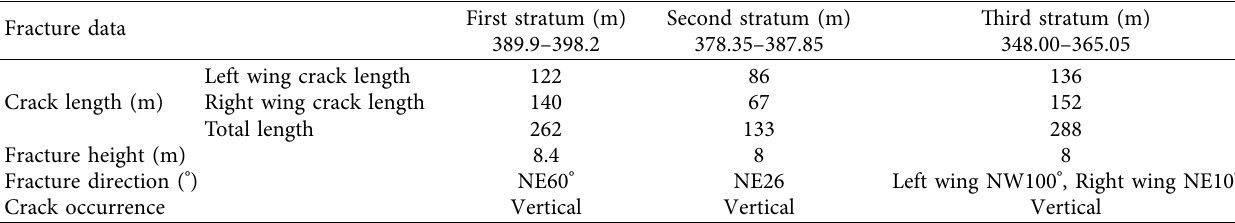
Figure 12: Monitoring results. (a) Distribution of microseismic events in the first stratum. (b) Distribution of microseismic events in the second stratum. (c) Distribution of microseismic events in the third stratum. Table 2: Monitoring results for the TXZL-01